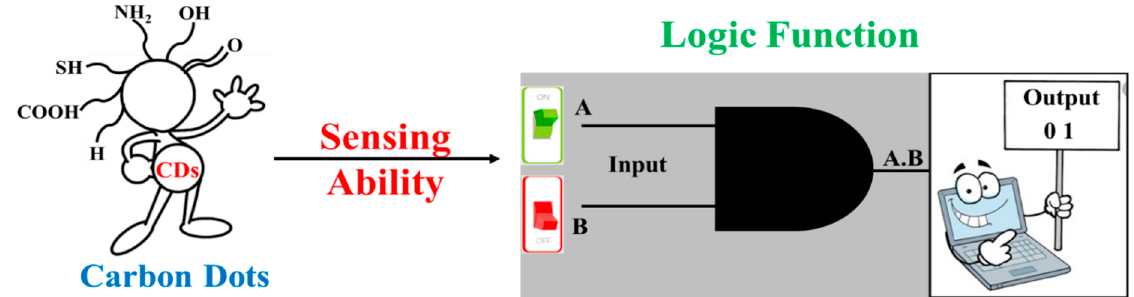
Figure 1. Carbon dots and their application in logic function based on their sensing ability.